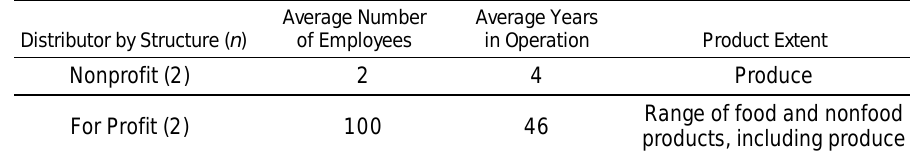
Table 2. Distributor Research Participants and Identifiers of Operation and